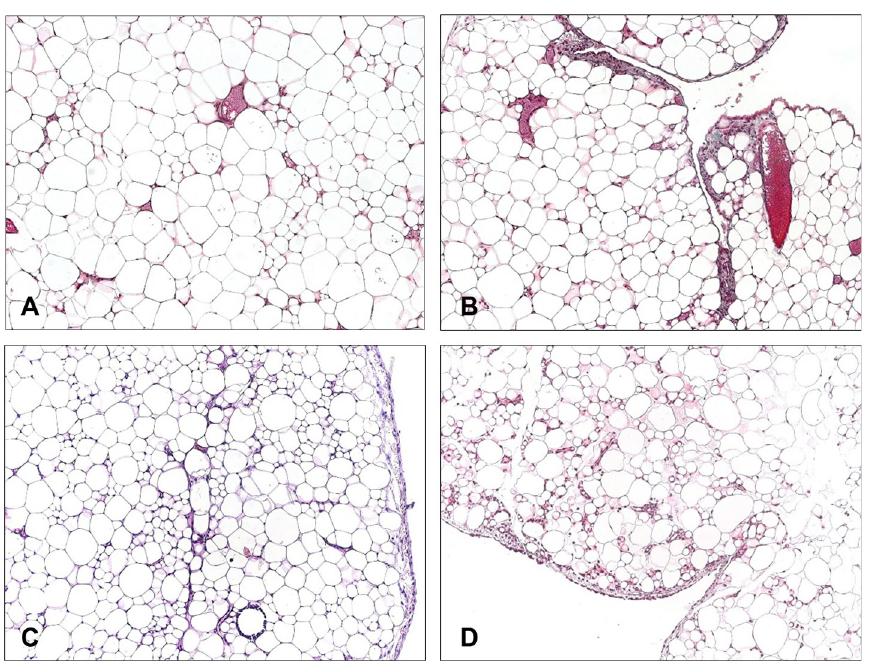
Fig 12. Morphological studies in non-injured omentum. Light microscopy micrographs (A, B and D, Masson´s trichrome staining, 100x magnification; C, hematoxylin-eosin, 100x magnification) of samples of omentum (non- injured and not involved in adhesions) from animals implanted with different meshes: (A) Preclude, (B) Surgipro, (C) DynaMesh and (D) TiMESH.